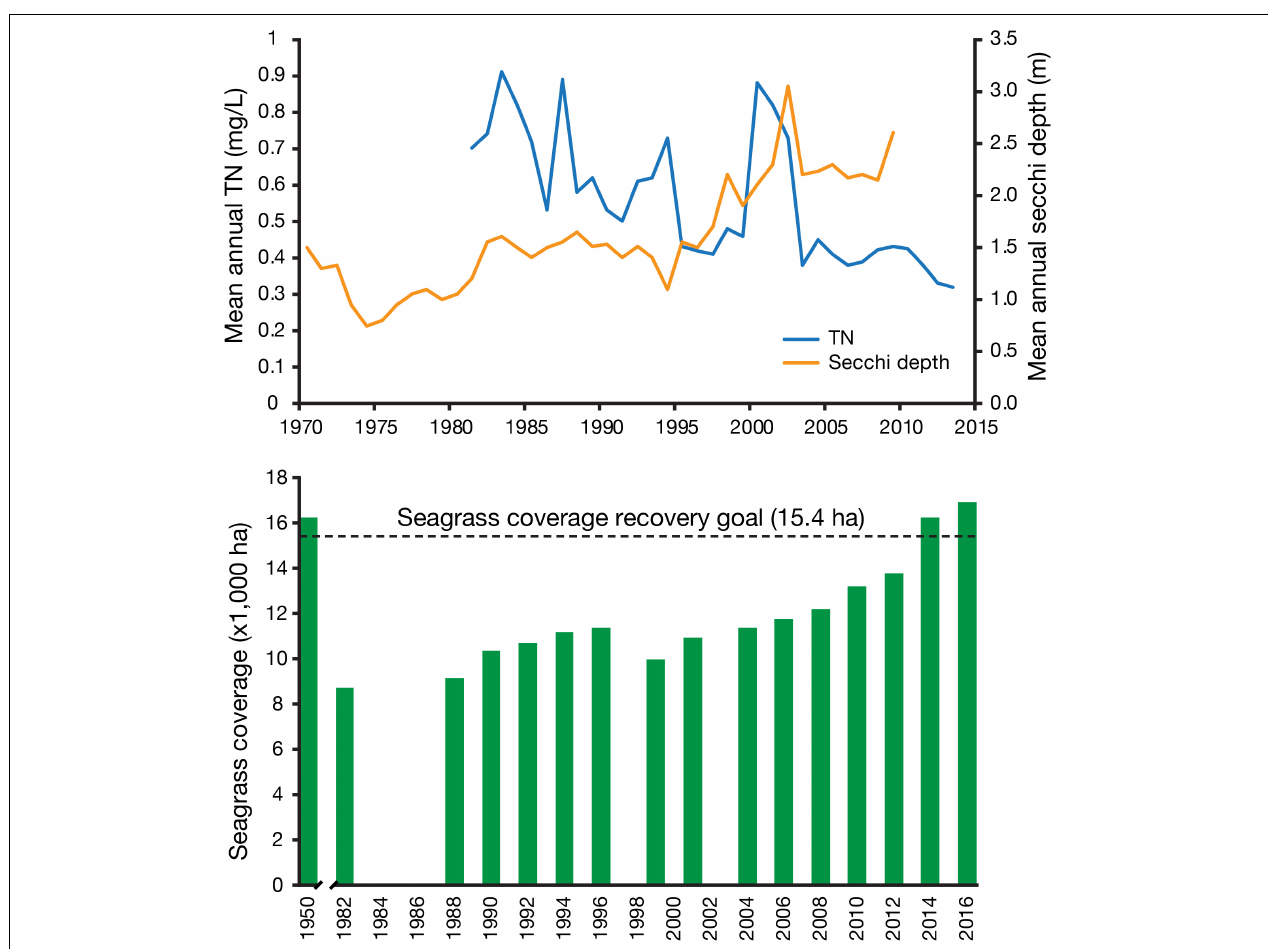
FIGURE 2 | Changes in the mean annual concentrations of total nitrogen (TN) and mean Secchi depth for the middle portion of Tampa Bay, FL, United Sates (top) . Extent of seagrass coverage in Tampa Bay (bottom) . Modified from Greening et al. (2014) and Sherwood et al. (2016), with permission of Holly Greening and Edward